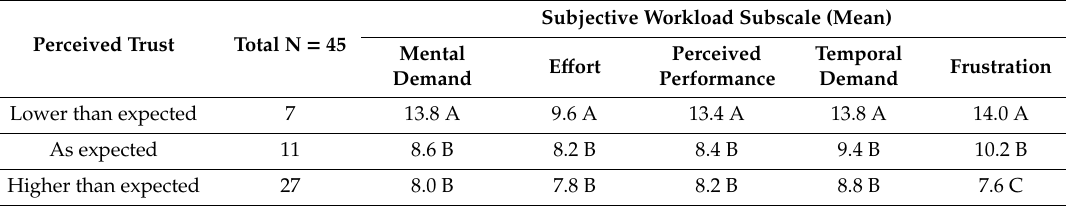
Table 3. NASA TLX subscales by perceived trust